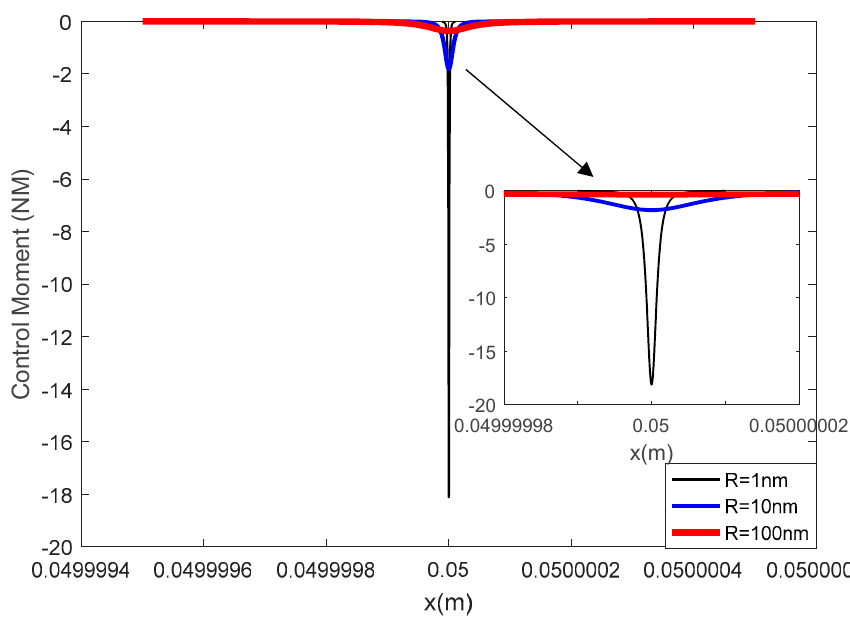
Figure 5. The effect of the AFM probe radius on the flexoelectric control moment.